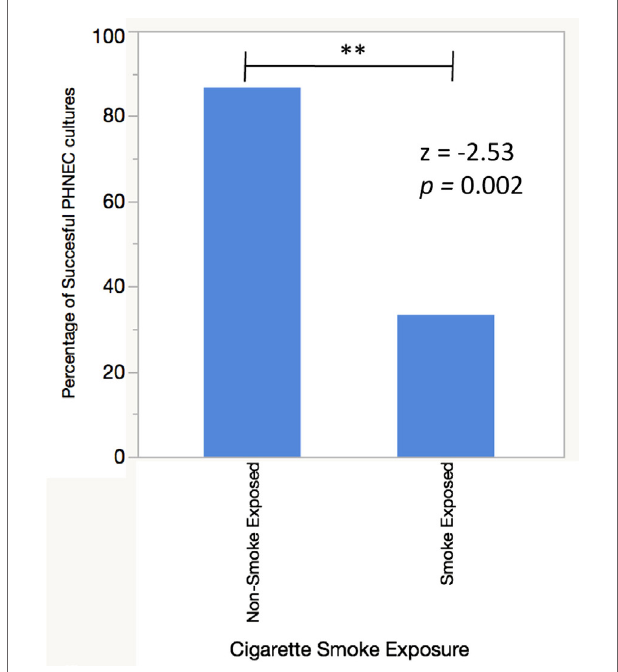
FigUre 1 | Phnec sampled from cigarette smoke-exposed individuals fail to grow into confluent ali cultures more often than Phnec from non-smoke-exposed individuals. A successful culture was defined as one that grew to confluency in a transwell and differentiated into a ciliated, mucus-producing air–liquid interface